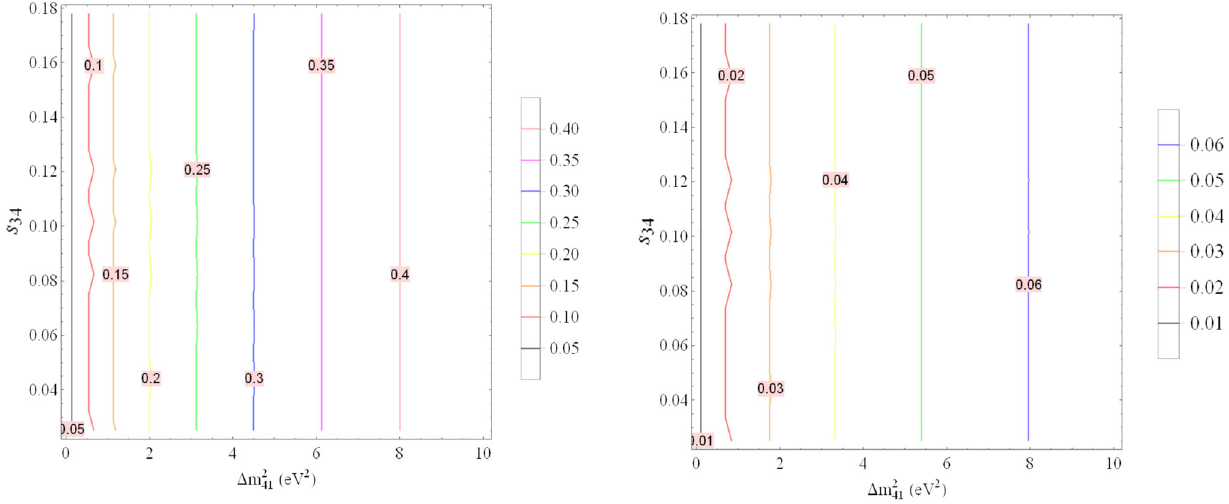
∈ ( 0 . 1 , 10 . 0 ) eV 2 41